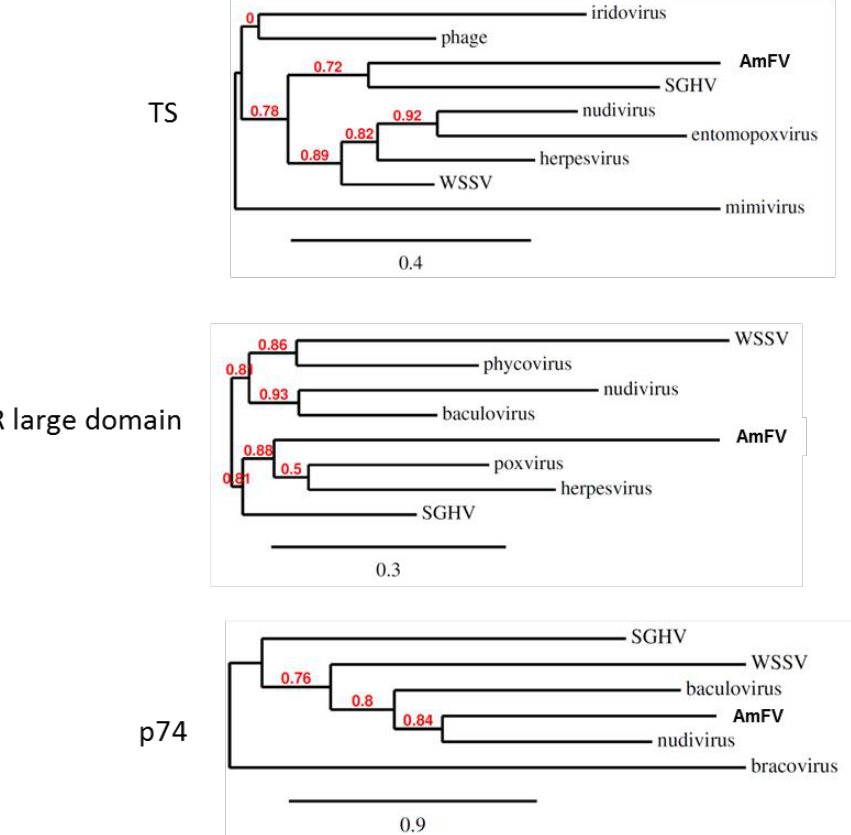
Figure 4. Phylogenetic analyses. Threes were built from thymidylate synthase (TS), ribonucleotide reductase (RR) and p74 proteins. Branch support values are indicated in red. GenBank entries from top to bottom: TS, gi|589287845|, gi|485725392|, gi|187903049|, gi|370702981|, gi|9631429|, gi|551484996|, gi|417072295|, and gi|55417112|; RR large